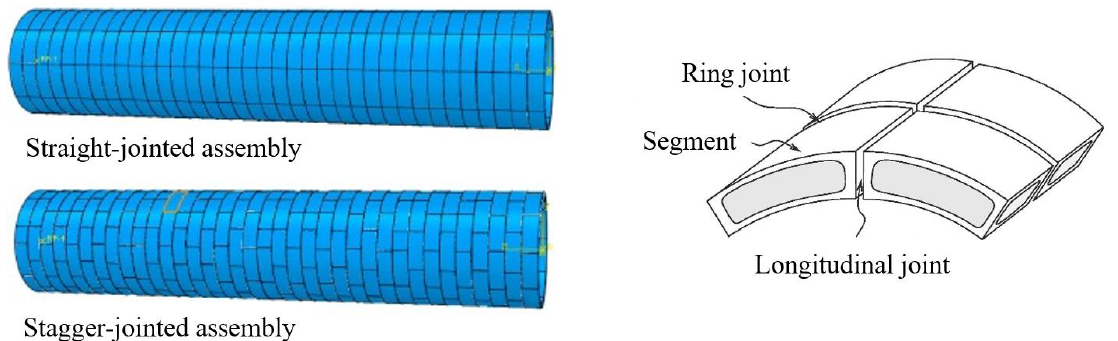
Fig. 1. Definition of lining components [4] (left) and assembly configurations [5]